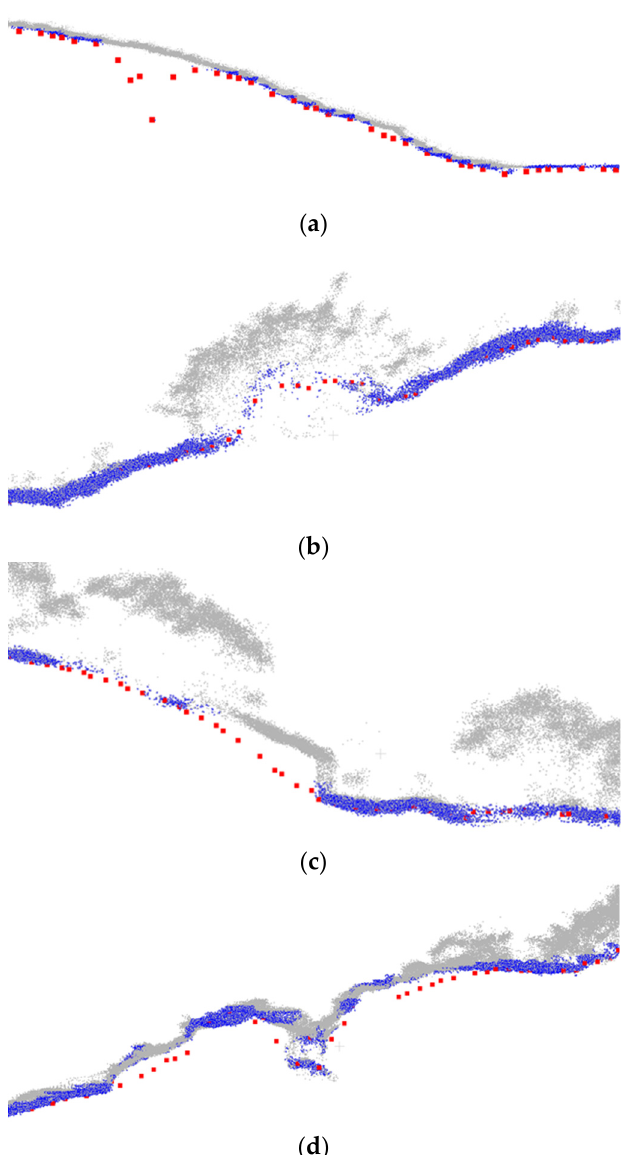
Figure 12. Derived DTM (in red), bare-earth points (in blue), and remaining points (in gray) using the cloth simulation algorithm for the challenging scenarios in Figure 10: ( a ) presence of noise/outlier points; ( b ) sparse points on the ground caused by dense vegetation; ( c ) rugged terrain with sudden elevation change; and ( d ) presence of an underground structure.